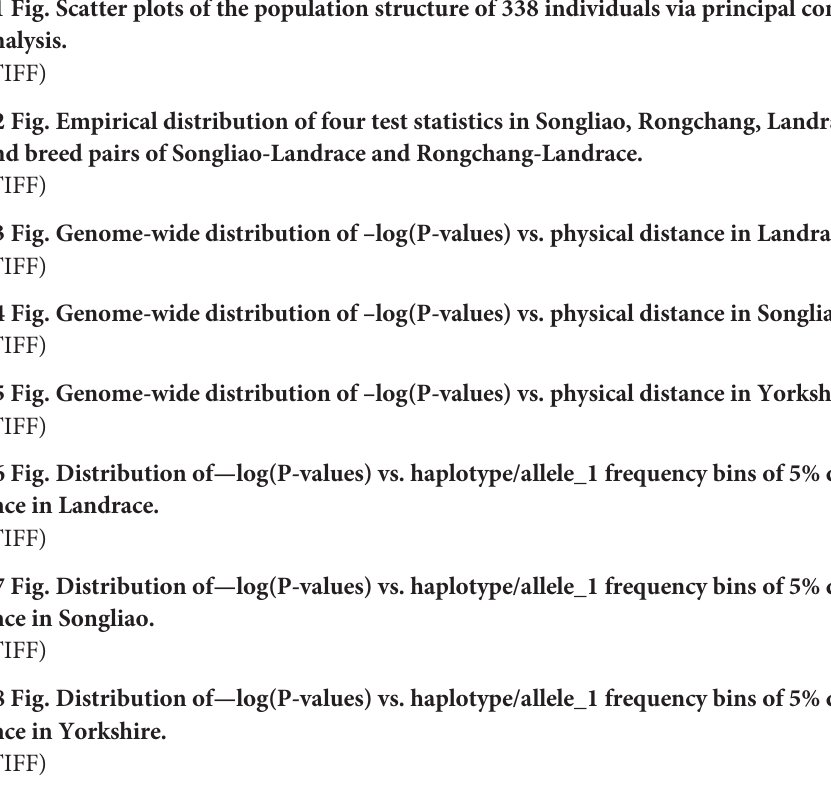
(TIFF) S2 Fig. Empirical distribution of four test statistics in Songliao, Rongchang, Landrance and breed pairs of Songliao-Landrace and Rongchang-Landrace. (TIFF) S3 Fig. Genome-wide distribution of – log(P-values) vs. physical distance in Landrace (TIFF) S4 Fig. Genome-wide distribution of – log(P-values) vs. physical distance in Songliao. (TIFF) S5 Fig. Genome-wide distribution of – log(P-values) vs. physical distance in Yorkshire. (TIFF) S6 Fig. Distribution of — log(P-values) vs. haplotype/allele_1 frequency bins of 5% differ- ence in Landrace. (TIFF) S7 Fig. Distribution of — log(P-values) vs. haplotype/allele_1 frequency bins of 5% differ- ence in Songliao. (TIFF) S8 Fig. Distribution of — log(P-values) vs. haplotype/allele_1 frequency bins of 5% differ- ence in Yorkshire.